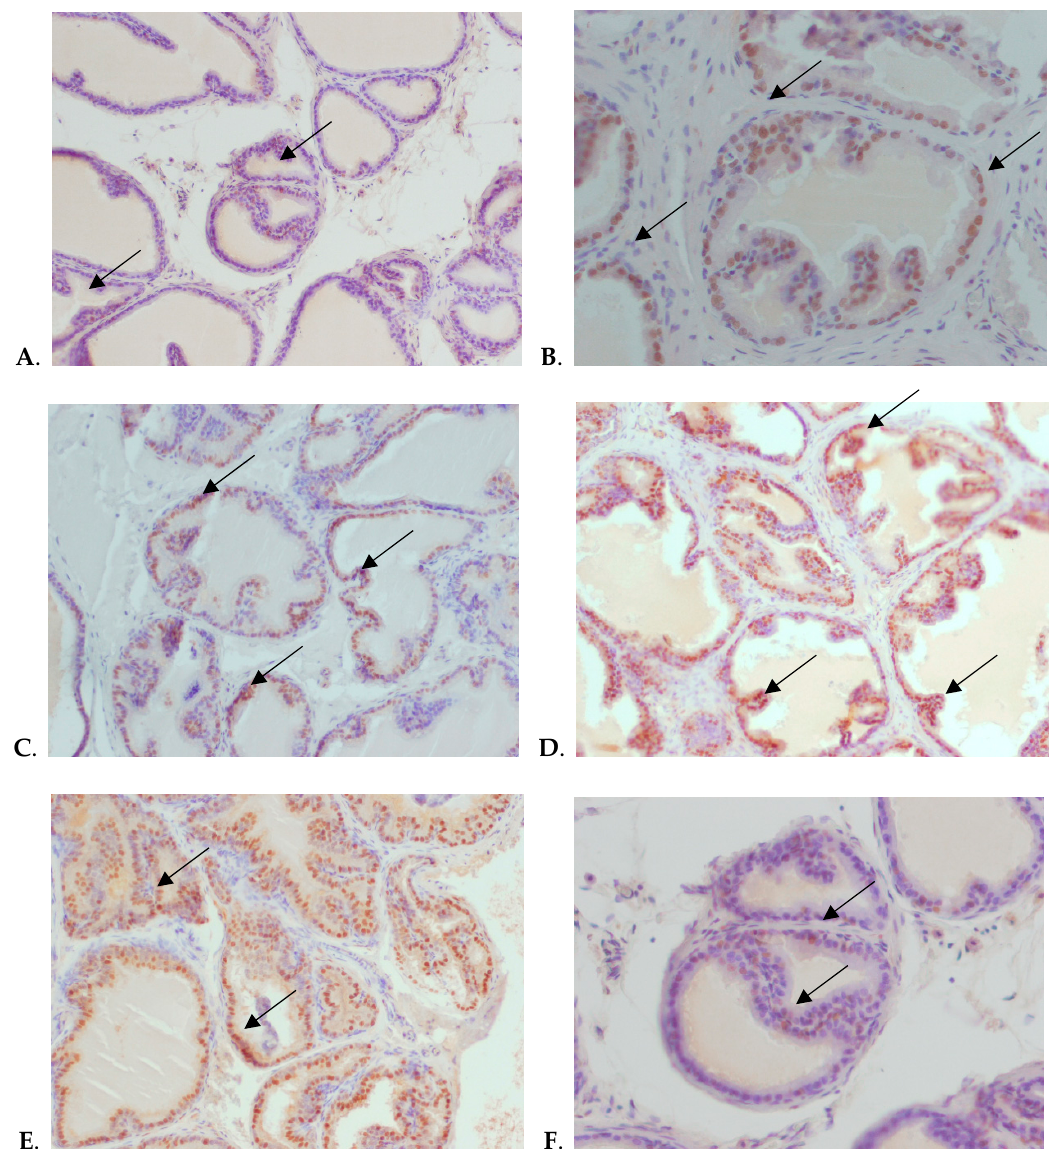
Figure 2. Immunohistochemical, nuclear localization of AR in the epithelial cells of V and DL prostatic lobes of the Wistar rats. ( A ) V, control, 30 days exposure, magnification × 200; ( B ) DL, Zn, 30 days exposure, magnification × 400; ( C ) V, Zn, 30 days exposure, magnification × 200; ( D ) V, Zn, 90 days exposure, magnification × 200; ( E ) DL, Zn, 90 days exposure, magnification × 200; ( F ) V, Se, 90 days exposure plus 90 days postexposure period, magnification × 400. The epithelial cells with brown nuclei are positive for AR (arrows), whereas epithelial cells with blue nuclei are negative for AR.